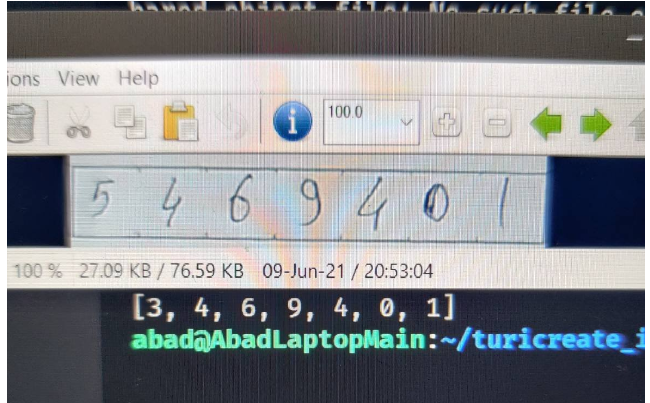
Figure 21. Digit classification